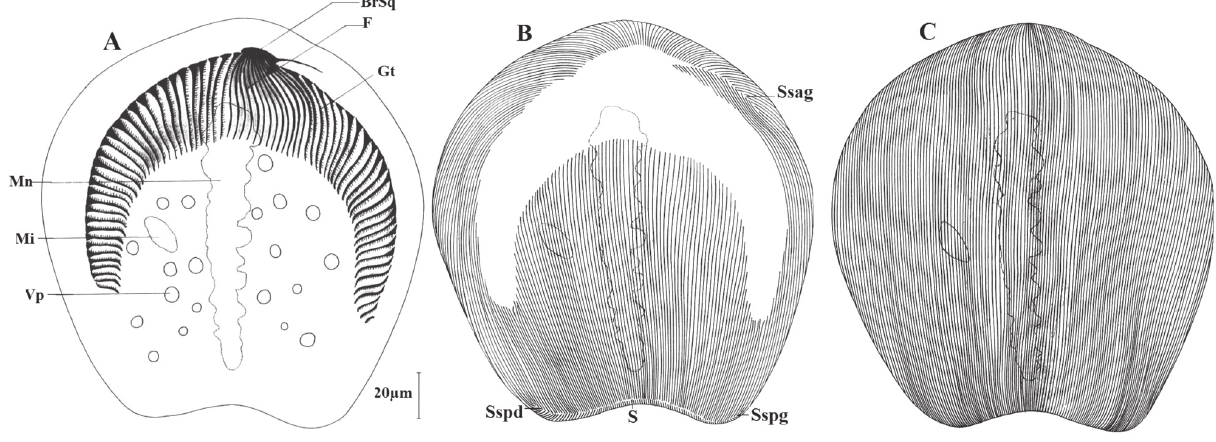
Figure 7. – Dicoelophrya nkoldensis n.